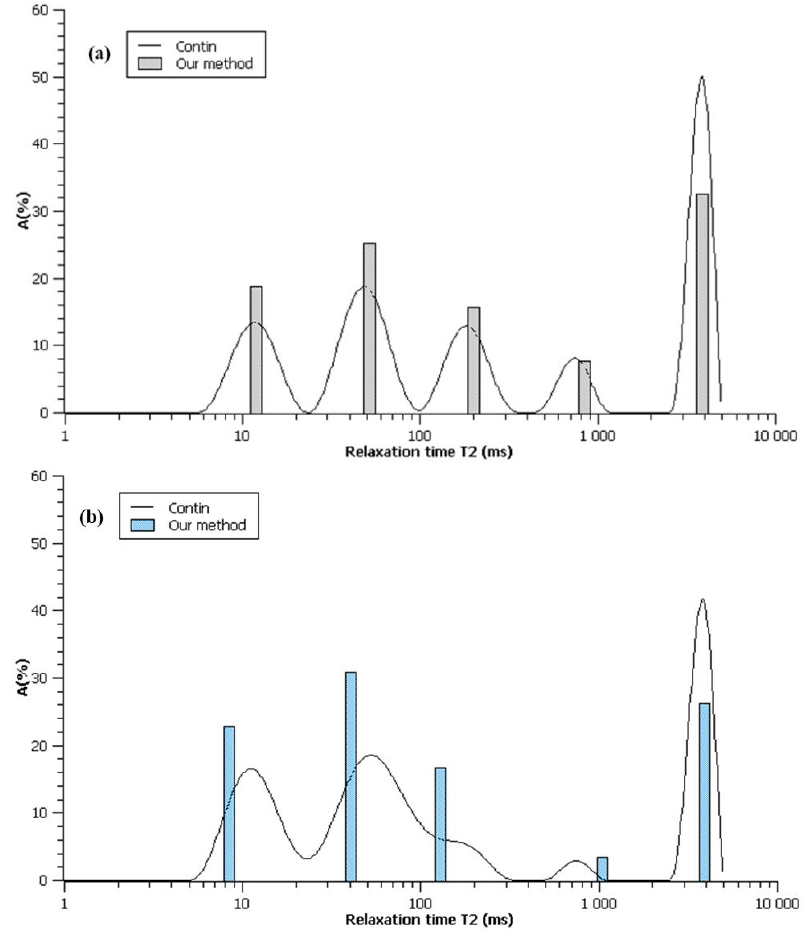
Figure 7. Distribution of T 2 for MC-1:4 ( a ) and MC-1:6 ( b ) by CONTIN algorithm, compared to our results (logarithmic scale on horizontal axis).